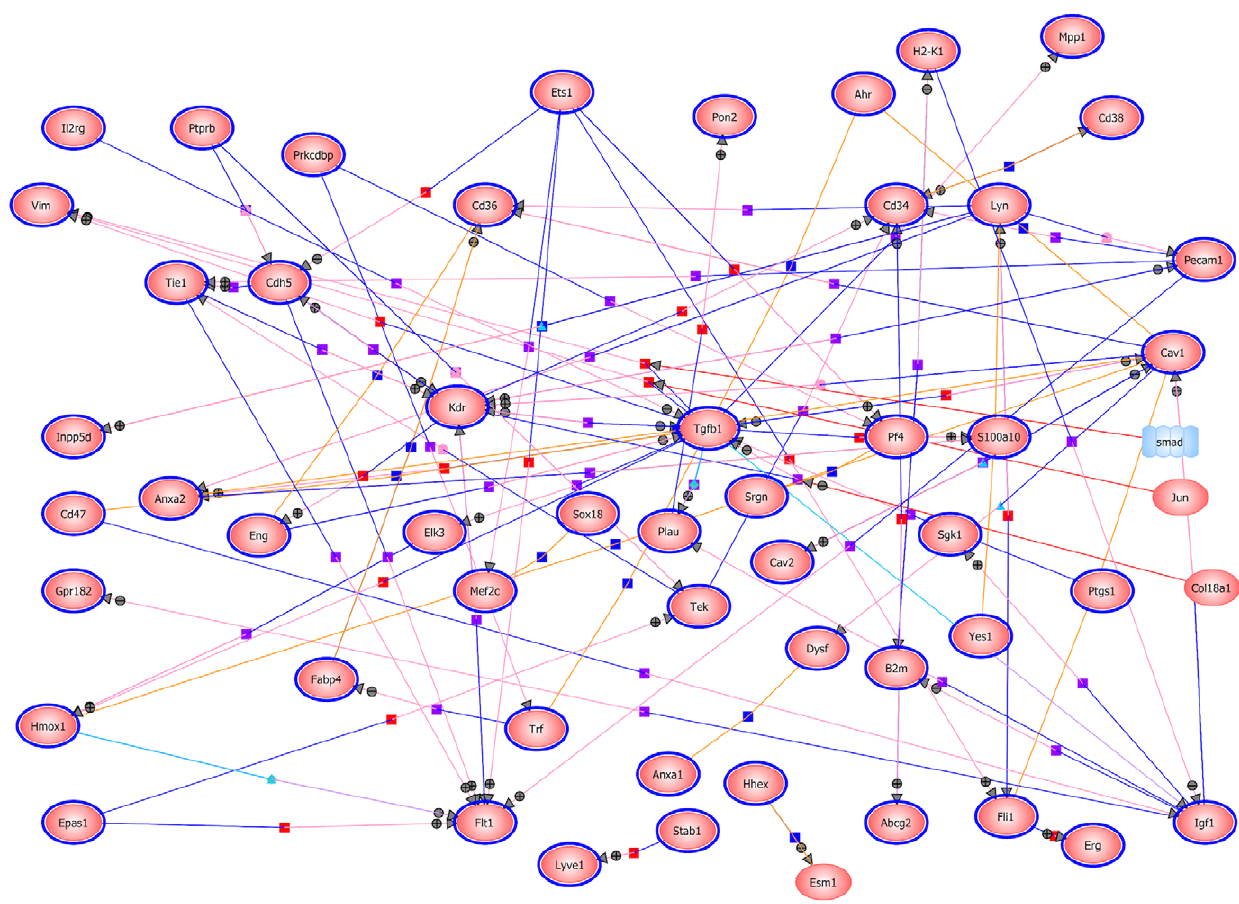
Figure 3. Molecular pathways analysis of genes with elevated expression in the kidney developing endothelial compartment. Generated with GeneSpring 11.0 using the 207 genes with elevated expression in the embryonic endothelial cells. Relations between encoded proteins are shape and color coded, with dark purple square = member, light blue triangle = transport, red square = expression, purple square = regulation, blue square = binding, orange circle = promoter binding, light blue diamond = metabolism, pink = protein modification.